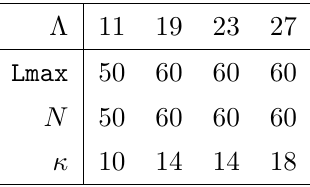
Table 3. Values of the various parameters for the bootstrap